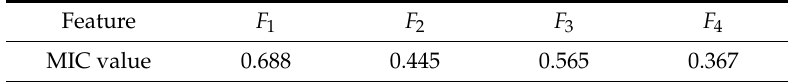
Table 2. The MIC values between the four features used for classification and classification label.